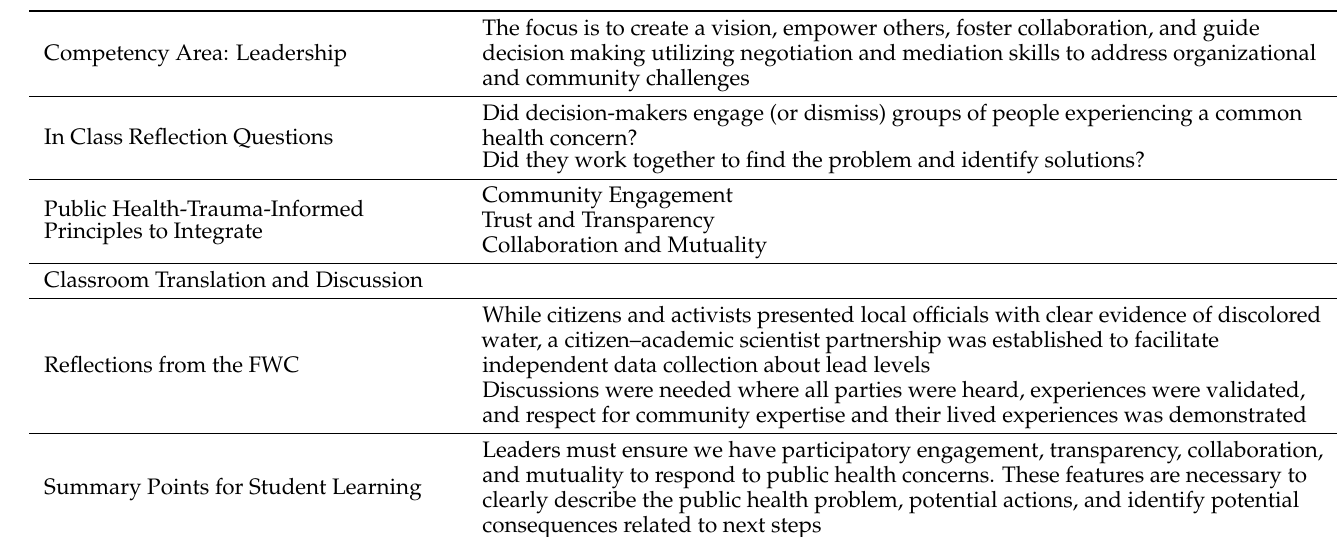
Table 2. Trauma-Informed Principles in Public Health: Addressing Public Health Leadership with Examples from the Flint Water Crisis.